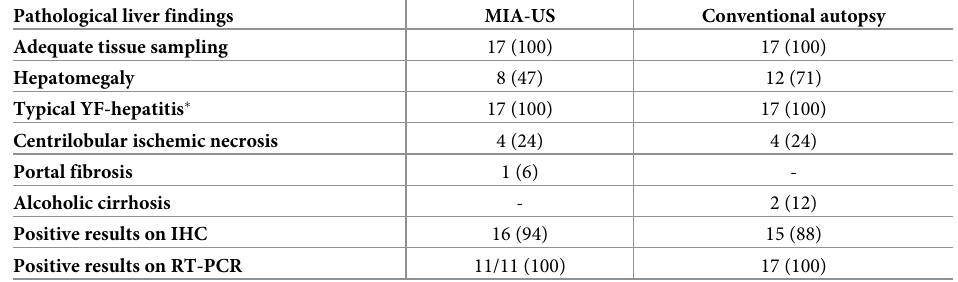
Table 2. Post-mortem liver findings in minimally invasive-ultrasound guided autopsy (MIA-US) and conven- tional autopsy of 17 patients with confirmed yellow fever. Pathological liver findings